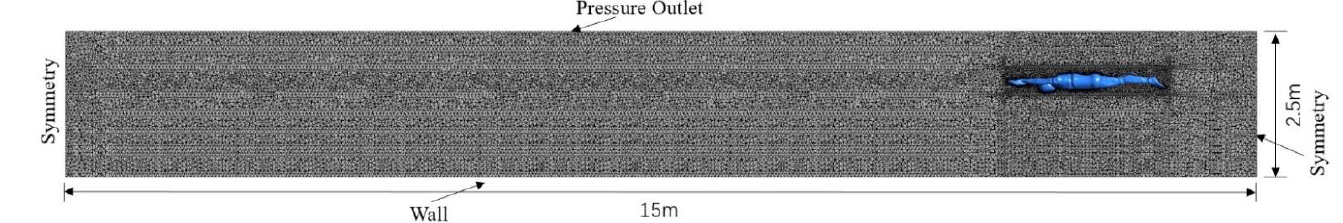
Figure 3. Computational domain and boundary conditions.